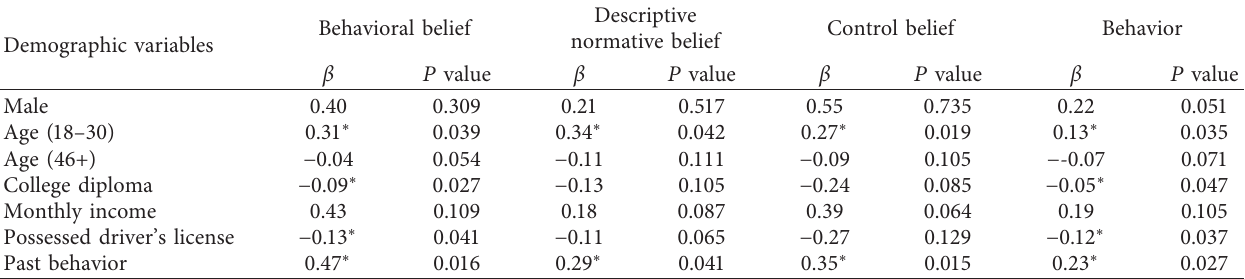
Table 7: Impacts of demographic variables on belief composite and behavior. Descriptive Behavioral belief normative Demographic variables